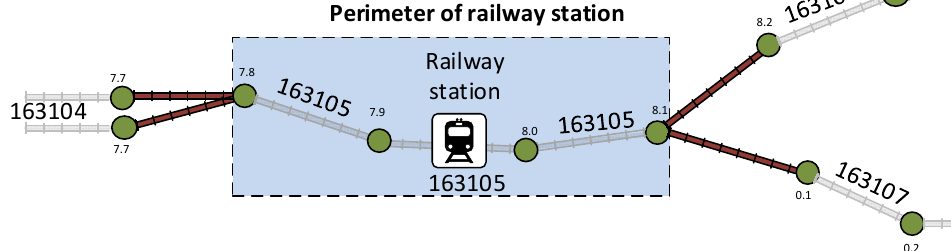
Figure 8. Construction of edges of individual TUDUs. The resulting situation is shown in Figure 9. Algorithm 3. Formation of edges between neighbouring TUDUs.